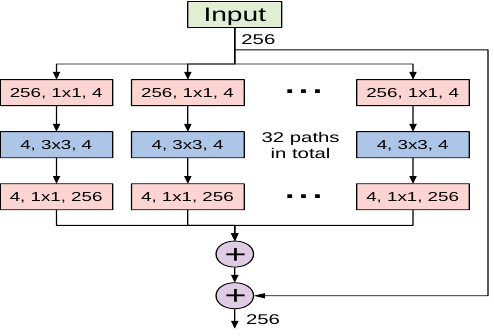
Figure 4. A basic ResNeXt block with cardinality of 32 as proposed in